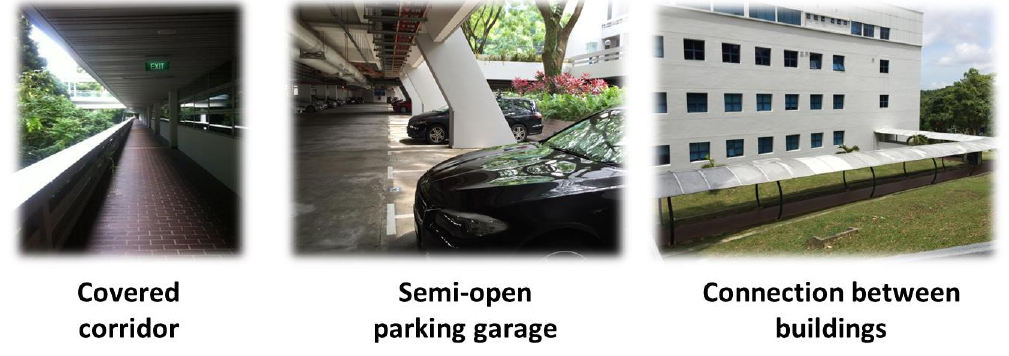
Figure 1. Typical scenes of semi-outdoor